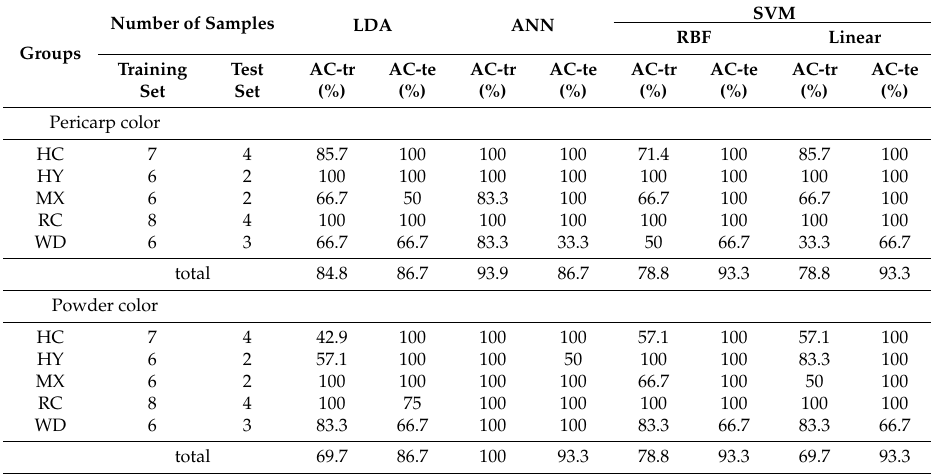
Table 2. Discrimination results (accuracy rate) of different models by color.